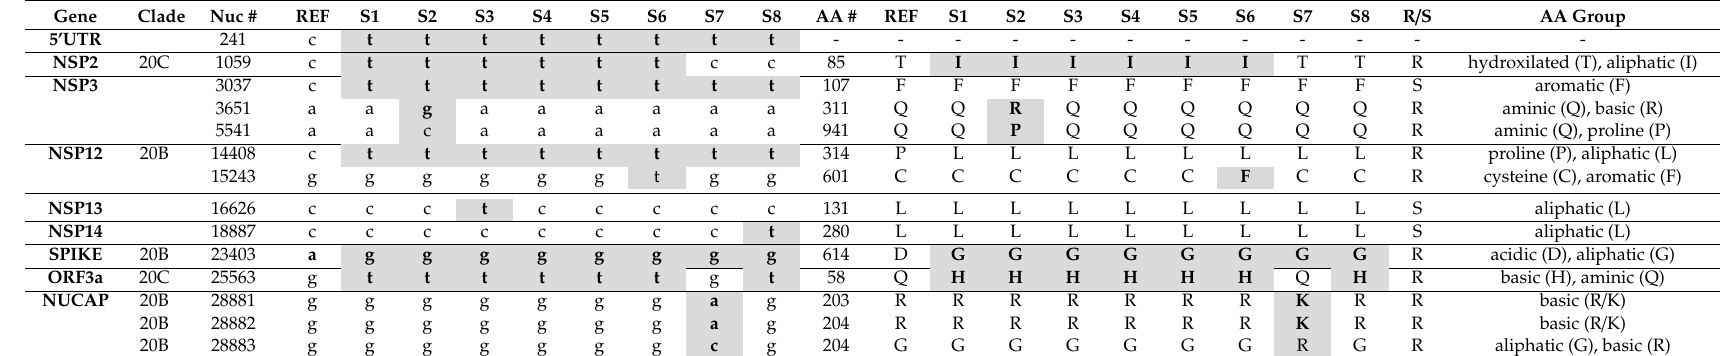
Table 3. Specific nucleotide and AA mutations in all infected